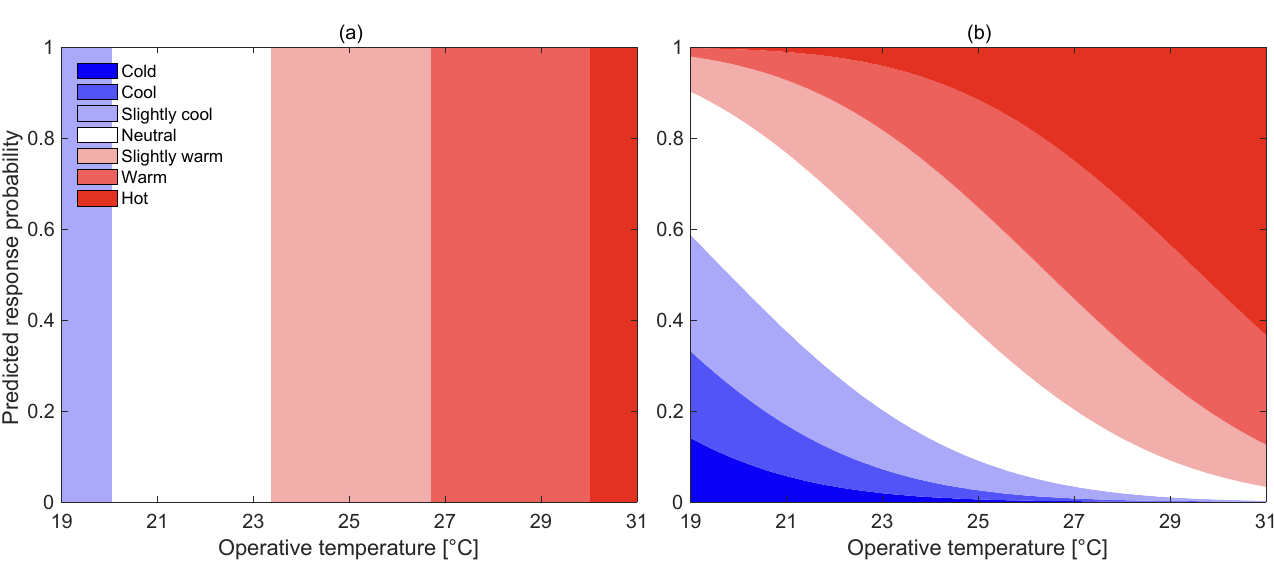
Figure 4. Thermal sensation profiles based on the ( a ) conventional and ( b ) probabilistic models. Algorithm 1. Pseudocode for deterministically establishing the response probability for each TSV category.